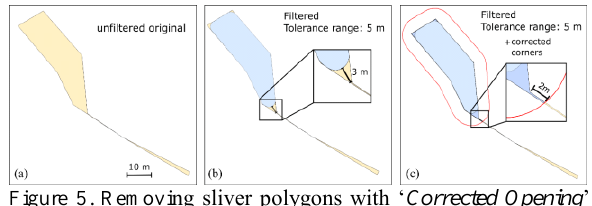
Figure 5. Removing sliver polygons with ‘ Corrected Opening ’ (Schorcht et al., 2016)